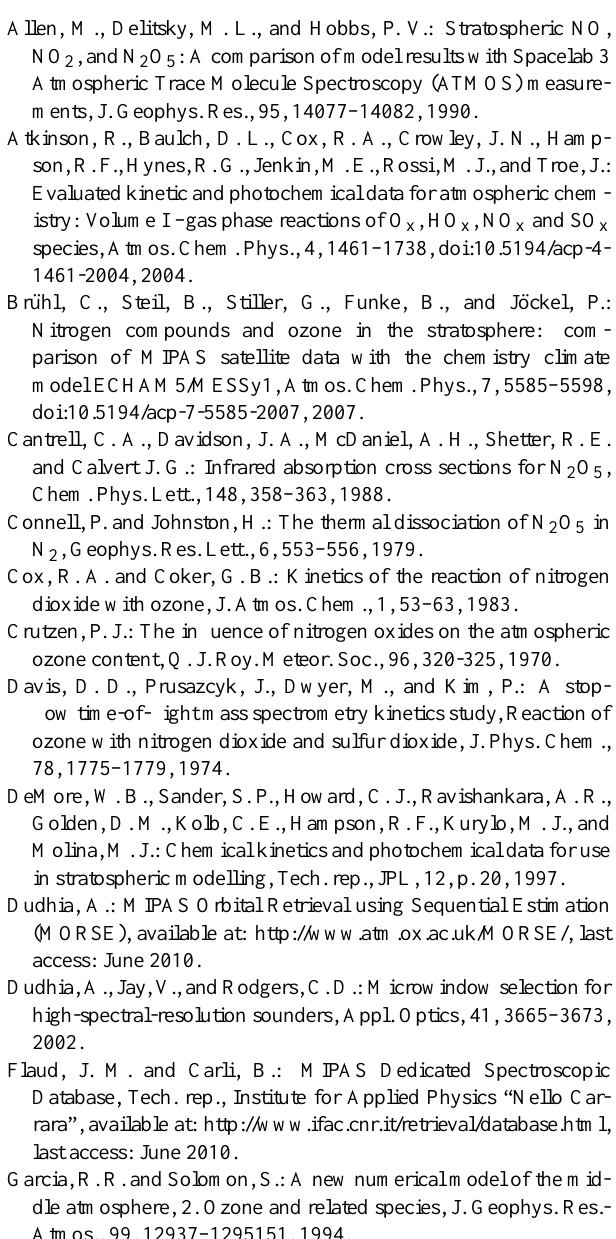
10 but at 39 km. Fig. 12. As in Fig.